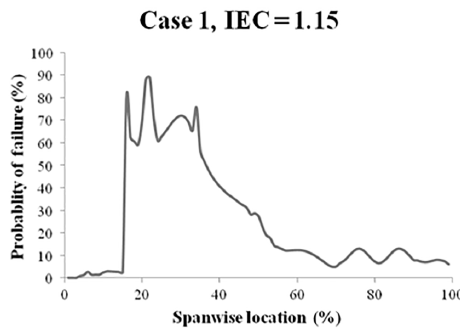
Figure 16. Probability of failure by location with reduced IEC safety